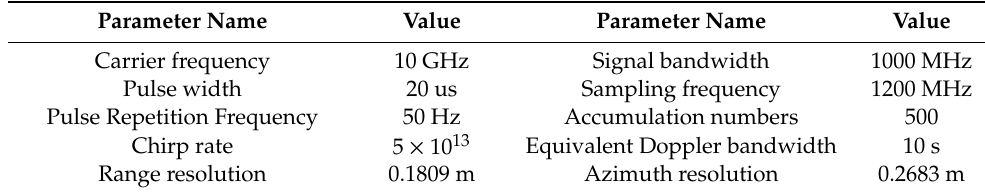
Table 1. Parameters of the Simulation.